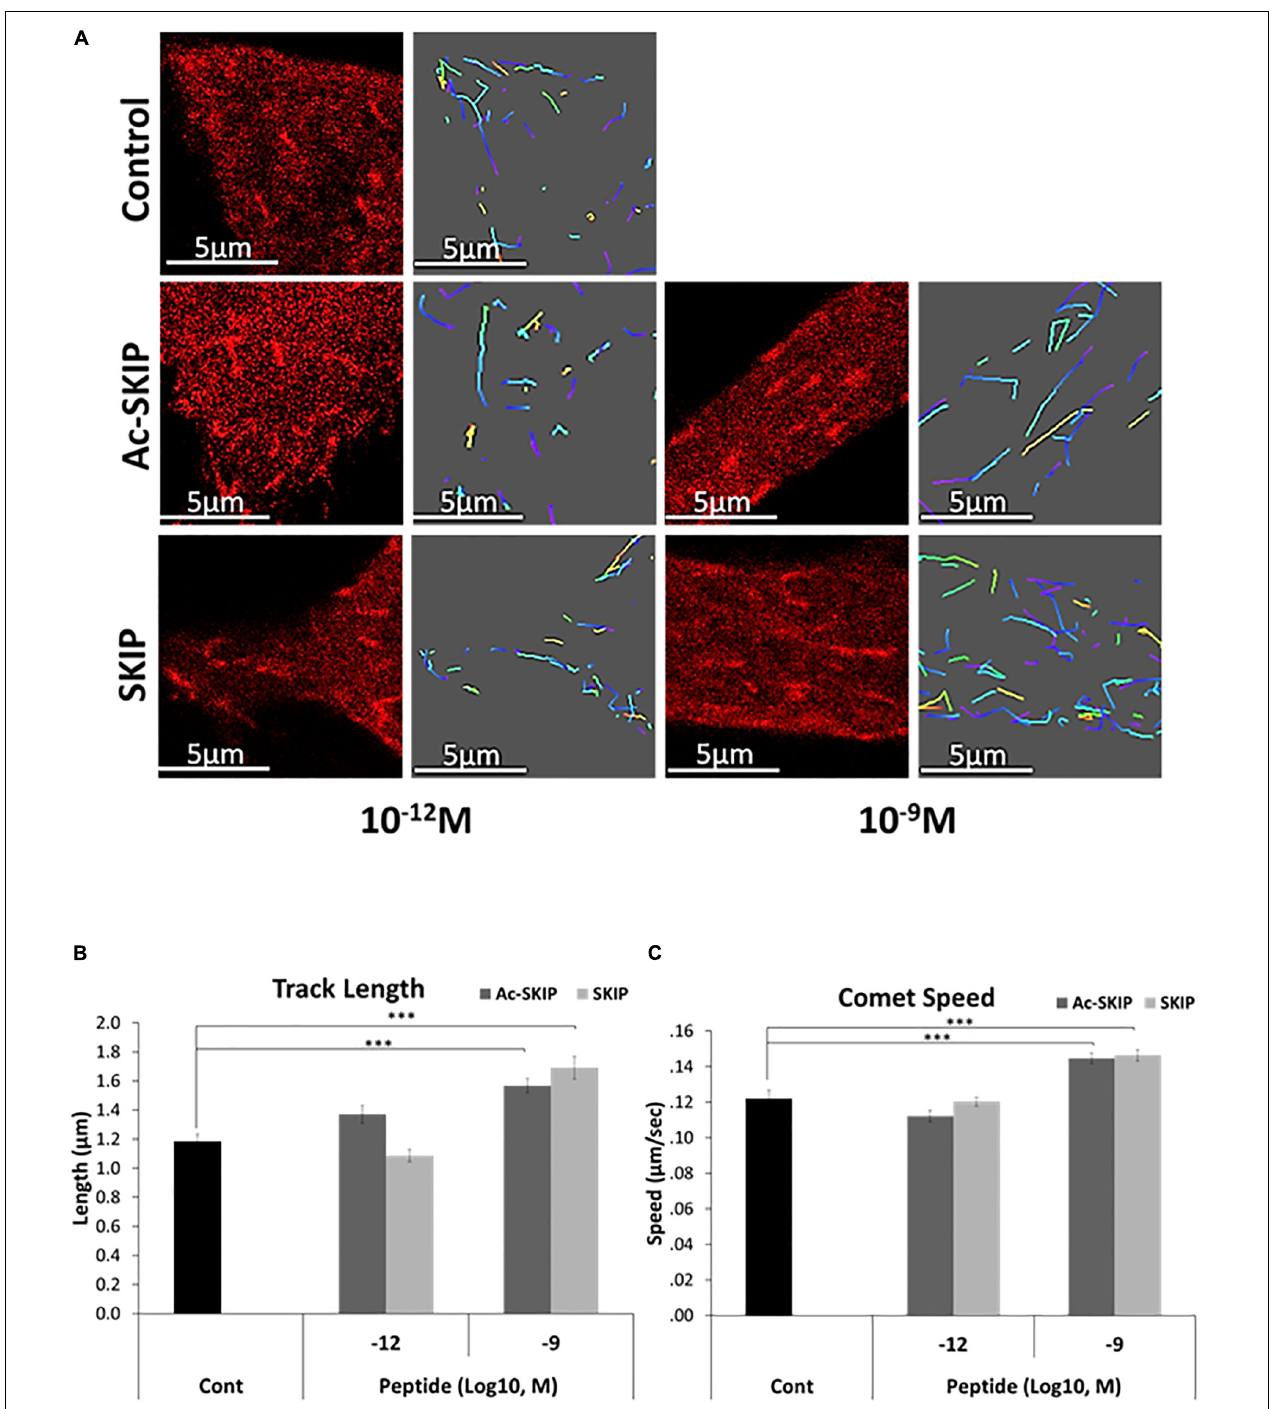
FIGURE 2 | SKIP and Ac-SKIP affect MT dynamics. (A) Live imaging of N1E-115 cells expressing EB1-RFP was performed after 4 h of treatment with Ac-SKIP or SKIP at 10 − 12 M and 10 − 9 M. Transfected cells without peptide treatment were used as a control group (“Control”). Time-lapse images were automatically captured every 3 s. during a 1 min using the Leica LAS AF software. Tracks of EB1 comet like structures presented as colored lines and were obtained by the Imaris software. Graphs represent quantification of the average track length (B) and comet speed (C) . Data were collected in unbiased fashion by the Imaris software, and statistical analysis of the data was performed by One-way ANOVA. Statistical significance is represented by ∗∗∗ P < 0.001. Comet length: Control, n = 46; Ac-SKIP 10 − 12 M, n = 29; SKIP 10 − 12 M, n = 20; Ac-SKIP 10 − 9 M, n = 62; SKIP 10 − 9 M, n = 43. Comet speed: Control, n = 47; Ac-SKIP 10 − 12 M, n = 30; SKIP 10 − 12 M, n = 20; Ac-SKIP 10 − 9 M, n = 65; SKIP 10 − 9 M, n =